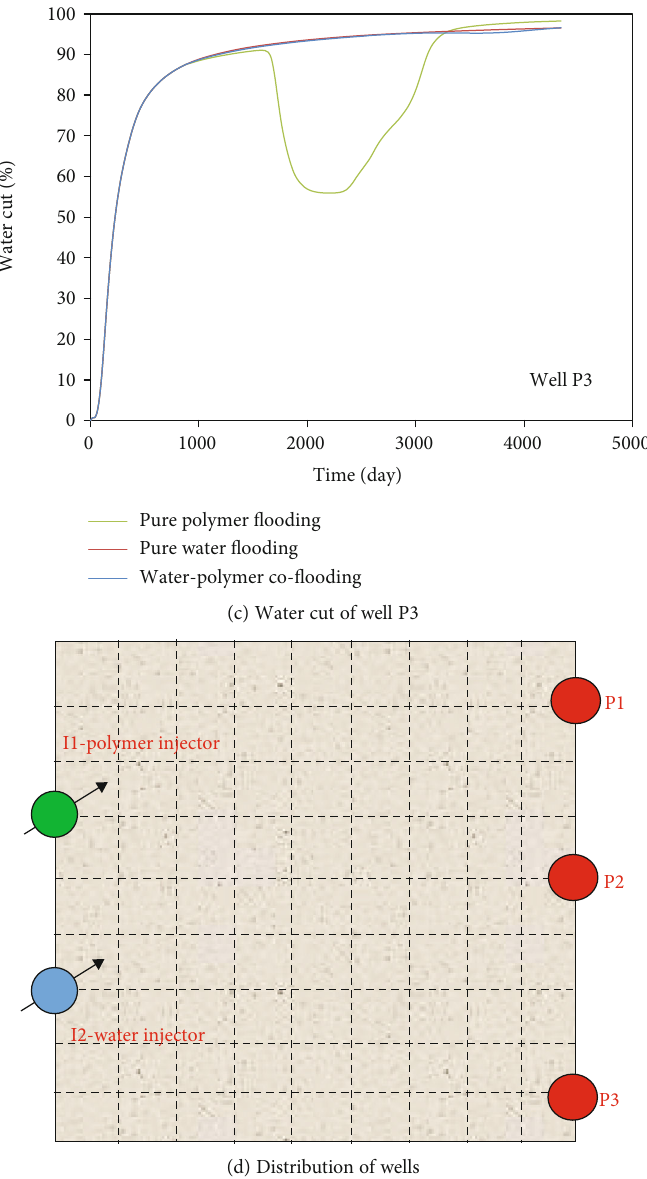
Figure 10: Water cut of wells in di ff erent